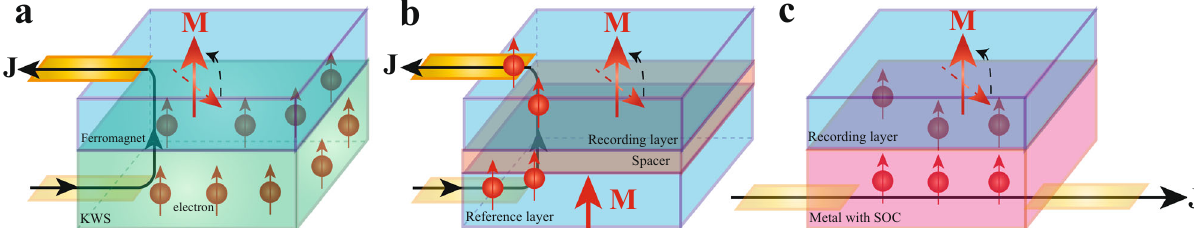
Fig. 4 The schematics of current induced magnetization switching in spintronic devices. a A Kramers Weyl semimetal/ferromagnet heterostructure. When a current J passes through the Kramers Weyl semimetal, the effective magnetic fi eld at the Kramers Weyl semimetal and the electrons injected from Kramers Weyl semimetal to the ferromagnetic layer provide a torque to switch the magnetization direction M ð Þ of the ferromagnetic layer. b A magnetic tunneling junction. The junction is made of a reference ferromagnetic layer and the recording ferromagnetic layer separated by a metallic or insulating spacer. The magnetization of the recording layer can be switched by the spin polarized electrons coming out of the reference layer. c A spin-orbit torque device 30 – 33 . The current induces magnetization at the metal layer through magnetoelectric effect (or the inverse spin galvanic effect). The effective magnetic fi eld at the metal/ferromagnet interface causes the magnetization switching in the ferromagnetic